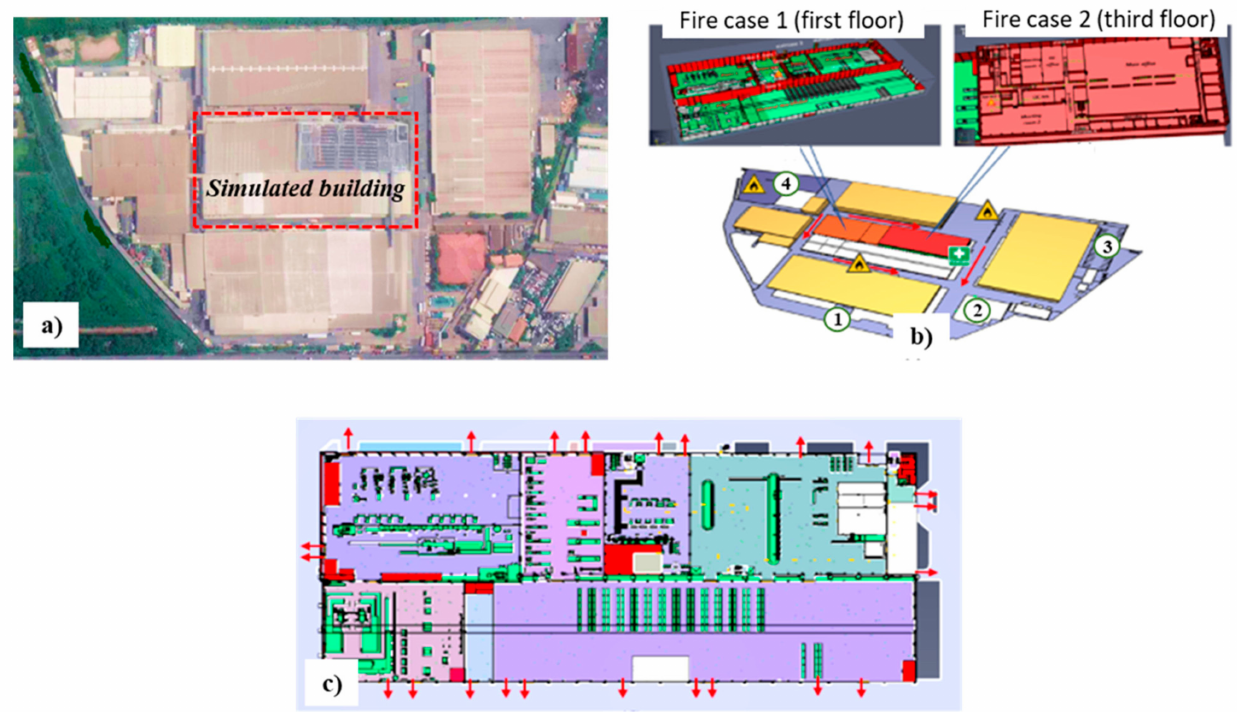
Figure 1. Home appliance factory ( a ) actual layout ( b ) simulated building with fire emergency ( c ) exit door